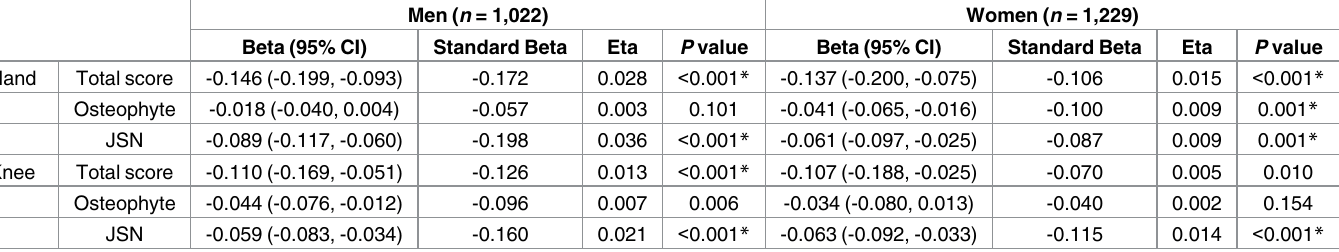
Values are regression coefficients from a multiple linear regression.